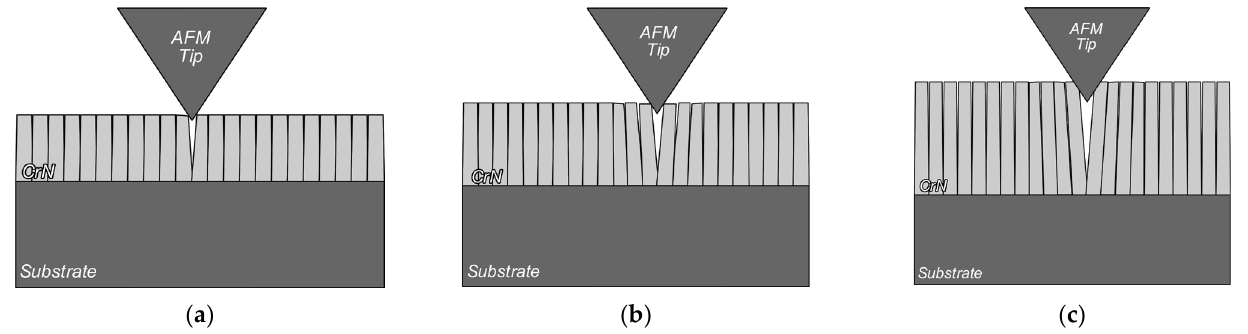
Figure 12. Mechanical explanations of the tip sample interaction when using DC power supply for the deposition times of ( a ) 5 min, ( b ) 10 min and ( c ) 15 min.